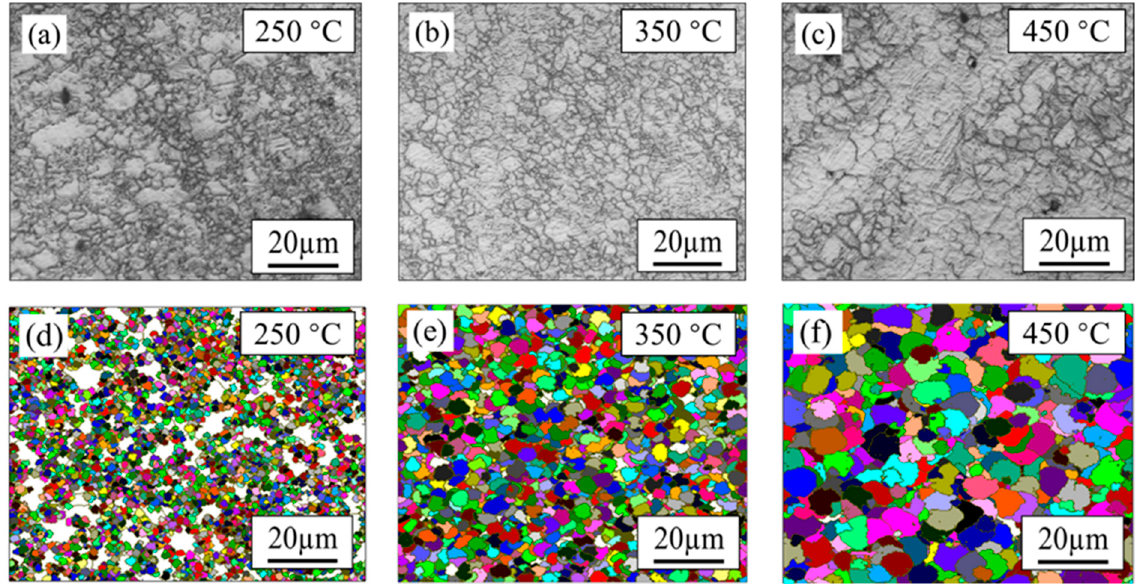
Figure 10. Comparisons between the experiment and simulated microstructures under different temperatures: ( a – c ) experiment, and ( d – f ) simulated.